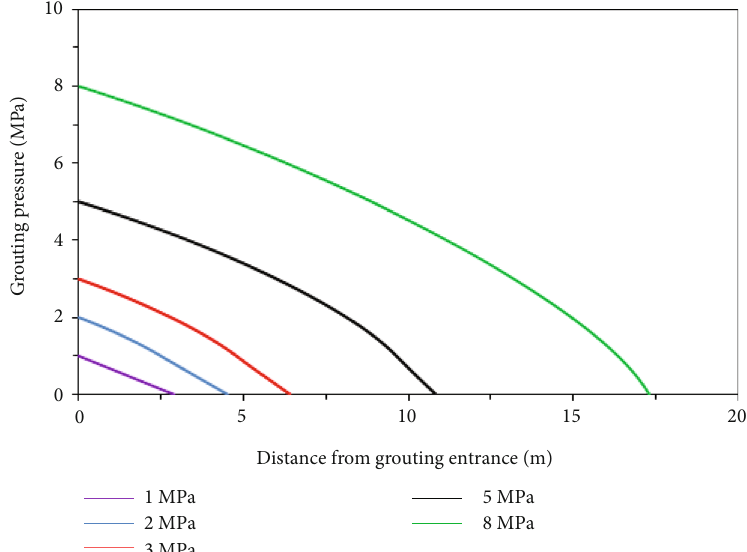
Figure 14: Curve of grouting pressure vs. distance for di ff erent grouting pressures.